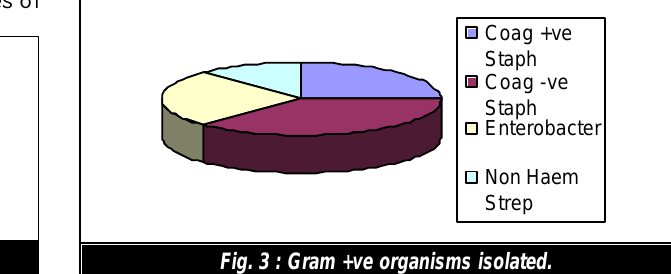
Fig. 2 : Gram -ve organisms isolated. Fig. 3 : Gram +ve organisms isolated. (Single organism with significant colony